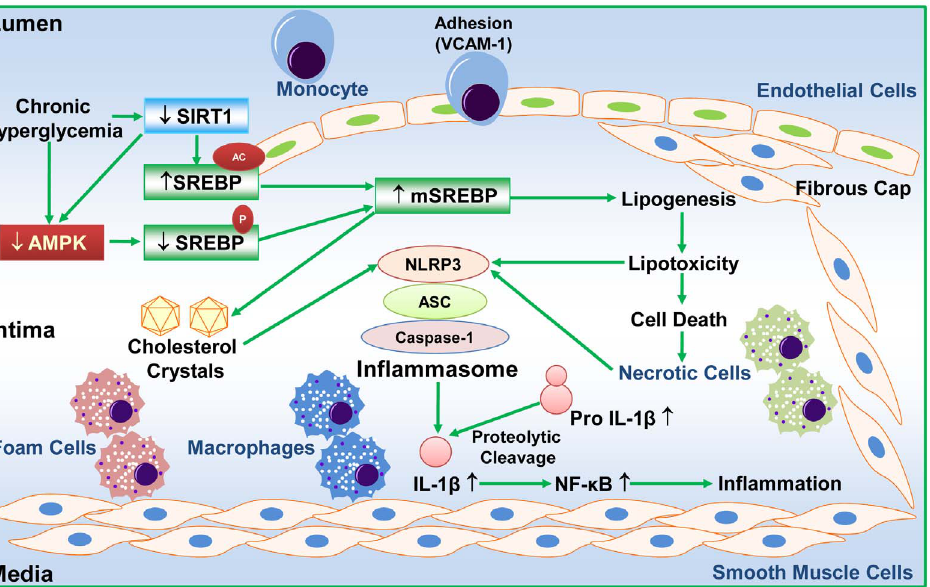
Figure 9. The proposed model for the association of SREBP-mediated lipotoxic signaling with NLRP3 inflammasome in advanced atherosclerotic plaques during diabetes. Prolonged hyperglycemia causes the integrated suppression of arterial SIRT1 and AMPK in the development of atherosclerosis. This coordinated dysregulation may contribute to the repression in SIRT1-mediated deacetylation of SREBP-1 and inhibition in AMPK-dependent Ser-372 phosphorylation of SREBP-1, thereby leading to the proteolytic activation of SREBP-1. Consequently, aberrant activation of SREBP stimulates expression of its target genes involved in de novo lipogenesis and cholesterol synthesis, promotes the formation of cholesterol crystals, and accelerates more lipid deposit in the arterial wall. On the other hand, the induction of the NLRP3 inflammasome, which is potentially triggered by sensing the toxic lipids, cholesterol crystals, and components of necrotic cells, possibly elicits caspase-1-dependent production of pro-atherogenic cytokine IL-1 b . As a result, excess IL-1 b production potentially activates vascular inflammatory response likely through the induction of NF- k B and its target genes such as VCAM-1 and iNOS, which ultimately causes eNOS reduction and vascular dysfunction. The inflammatory process may also promote the migration of smooth muscle cells from the media into the inflamed intima, contributing to the fibrous cap formation in advanced lesions. Collectively, activation of SREBP and elevation of NLRP3 inflammasome markers may explain much of complicated atherosclerotic characteristics, such as macrophage infiltration, endothelial cell dysfunction, smooth muscle cell migration and proliferation, deposition of cholesterol crystals, and formation of fibrous caps and necrotic cores.